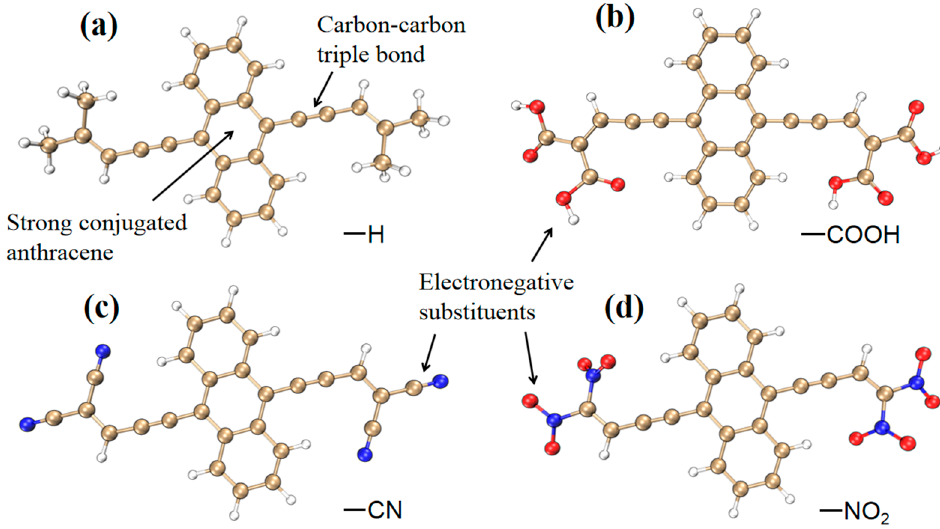
Figure 1. The optimized molecular geometry structures of different substituent group conjugated systems of -H ( a ), -COOH ( b ), -CN ( c ) and -NO 2 ( d